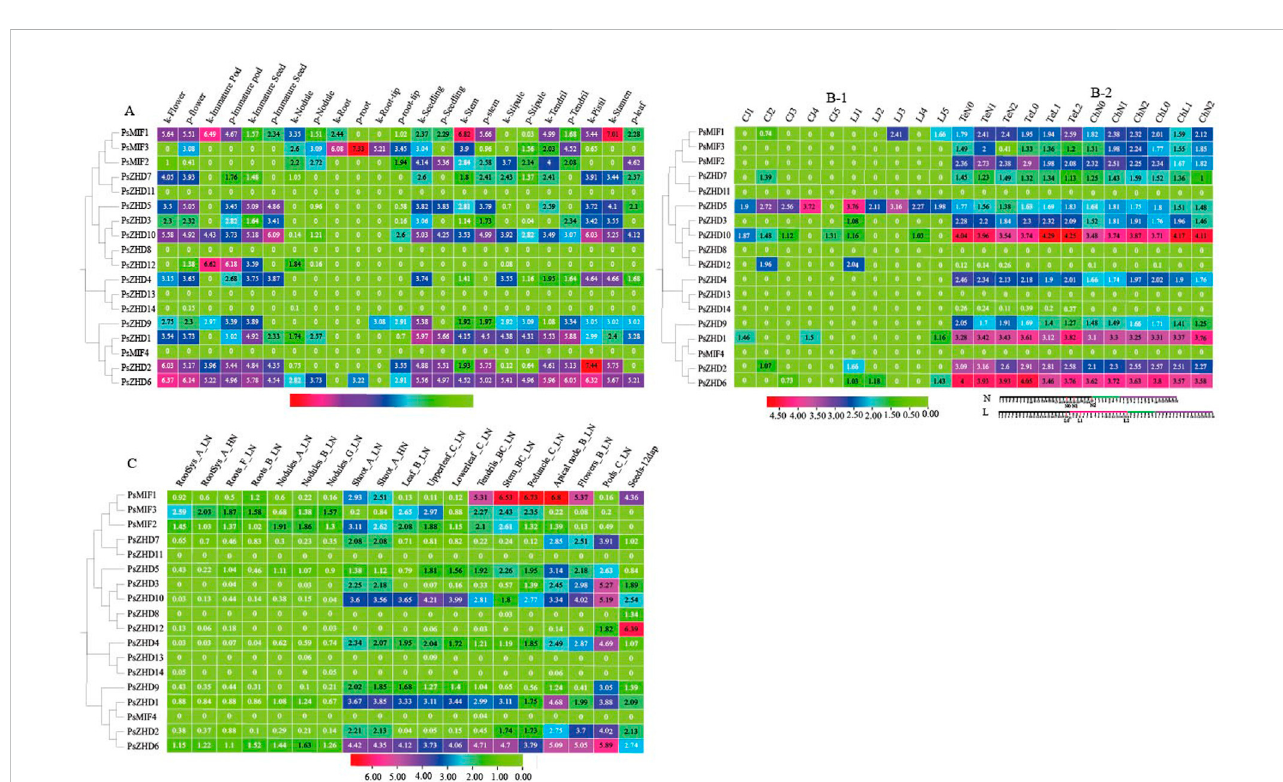
FIGURE 5 Expression patternsof PsZF-HD sin Different Tissues from Pisum sativum L.The heat map with clustering was created based on theFPKM valueof PsZF- HD s. Differences in gene expression changes are shown in colour as the scale. (A) The expression pattern of PsZF-HD genes in the fl ower, immature pod, immature seed, nodule, root, root-tip, seeding, stem, stipule, tendril, pistil, stamen, leaf of Two pea varieties with signi fi cant phenotypic differences(Kaspa variety and Para fi eld variety). (B-1) Expression of PsZF-HD s gene in fi ve stages of immature pod development. (B-2) The expression pattern of PsZF-HD genes in the leaf under different low-temperature stress. Scheme of the experiments and samplings of RNA-sequencing (RNA-seq) experiments:low temperature(L)treatmentandcontrol(N),lowtemperatureinfuchsia,freezingindeepskyblue,andrecoveryperiodindarkviolet. (C) Theexpressionpatternof PsZF-HD genes in different tissues of pea: The sampling points are shown in Supplementary File S3.